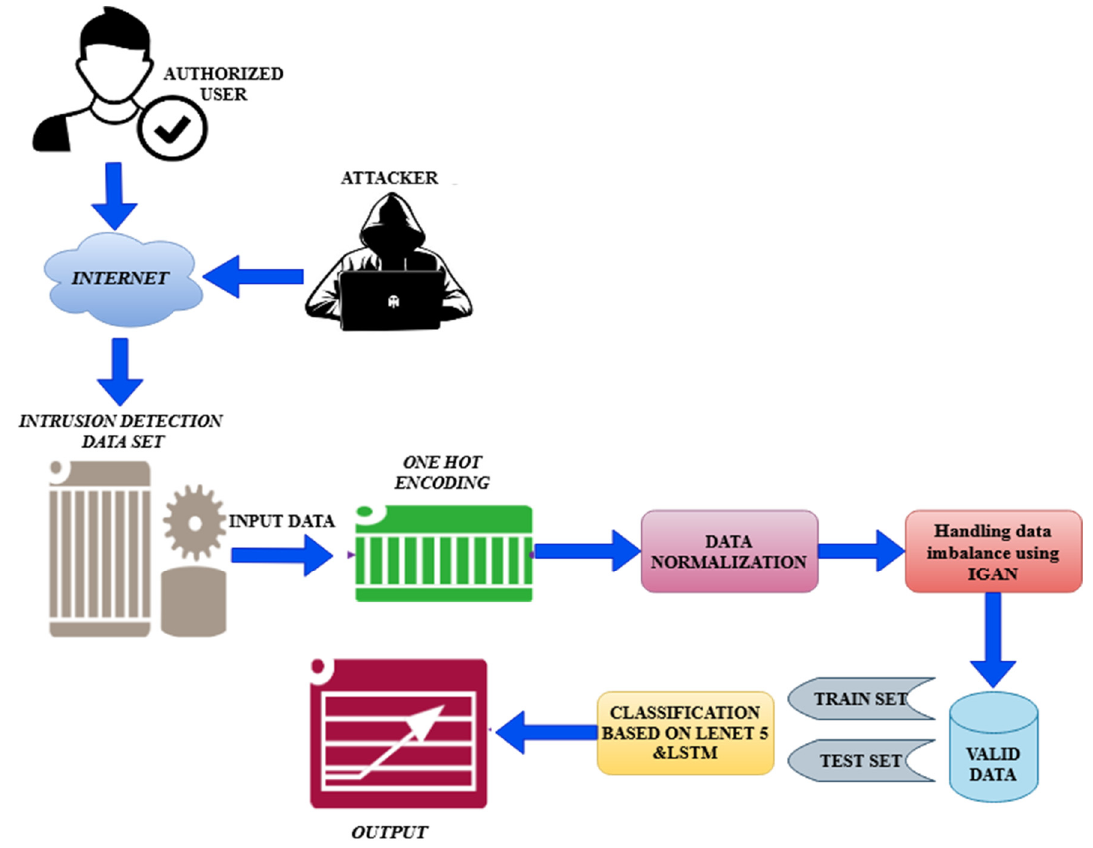
Figure 1. Architecture diagram of the proposed methodology.